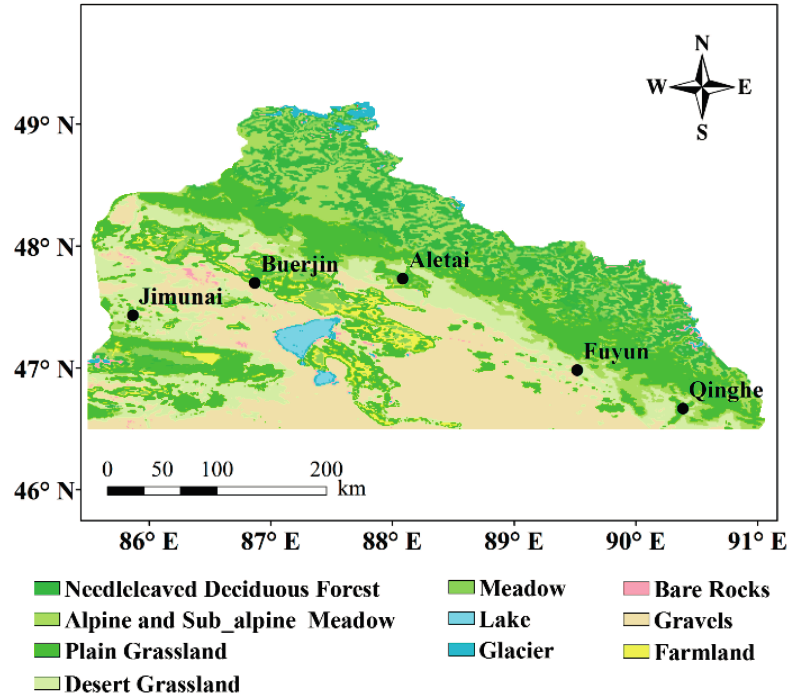
Figure 2. The geographic locations of five sites in the Altay region of Northern Xinjiang, China on the land cover map of approximately 1 km spatial resolution